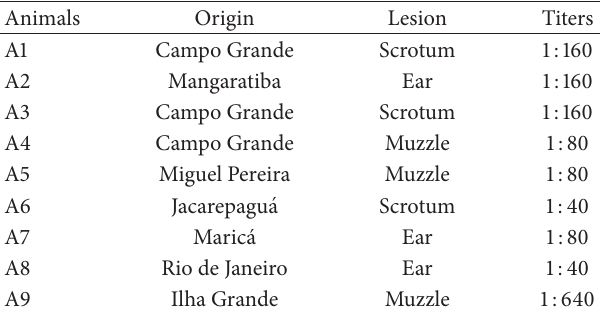
Table 1: Geographical origin, localization of lesions, and IFAT titers of the animals studied.